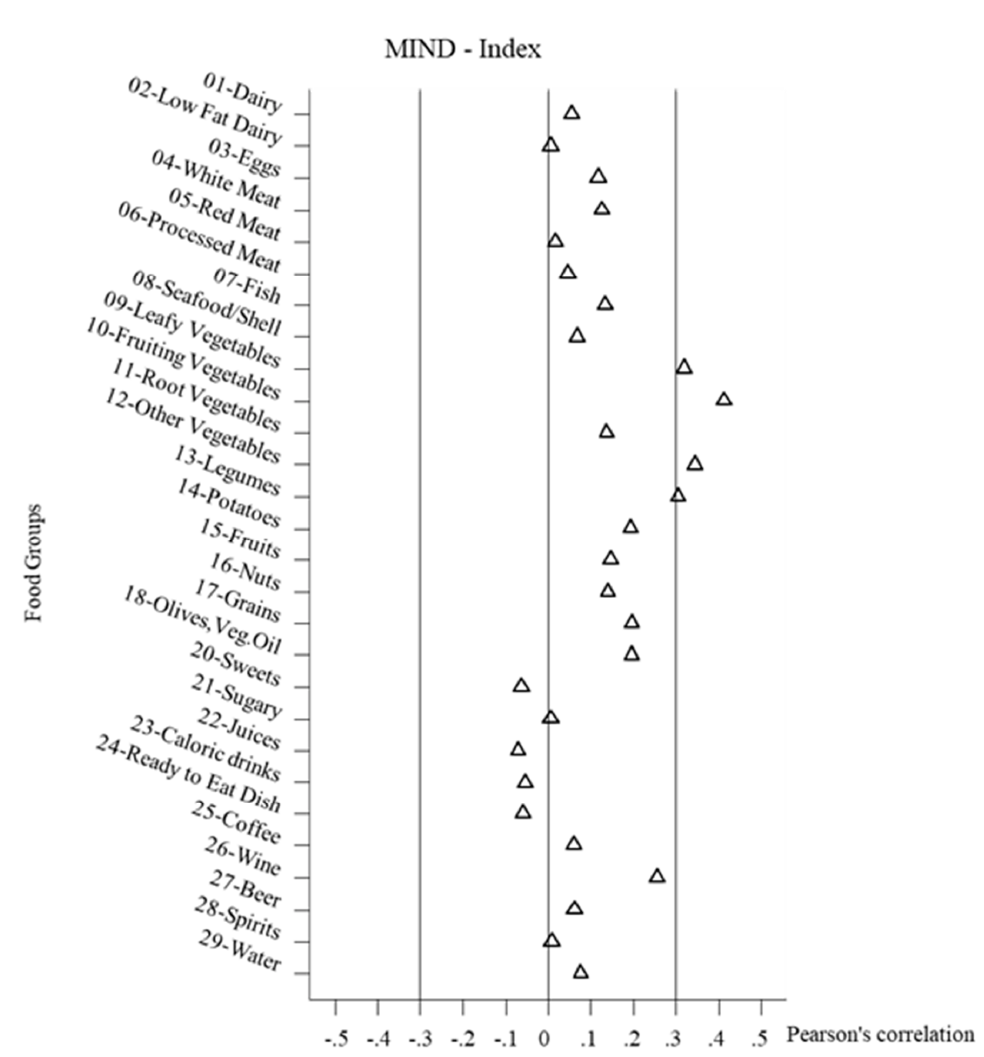
Figure 4. Pearson’s correlation between food groups intake and MIND-Index. MIND, Mediterranean- 319 DASH intervention for neurodegenerative delay. 320